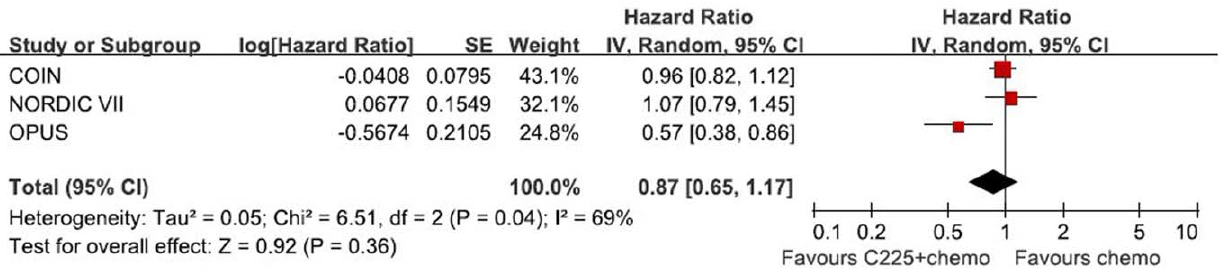
Figure 6. Randomized effect model on HR of PFS in Cetuximab subgroup. The pooled HR of PFS in cetuximab subgroup is symbolized by a solid diamond at the bottom of the forest plot and the width of which represents the 95%